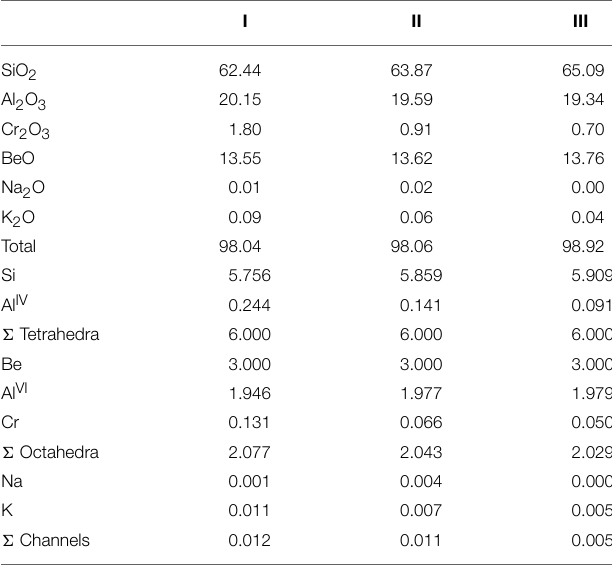
The analytical points are reported in Figure 3 . Crystal-chemical formulae were based on 18 oxygen atoms pfu (per formula unit). The tetrahedral site-population was constrained to be 9 apfu, Be was calculated by stoichiometry.